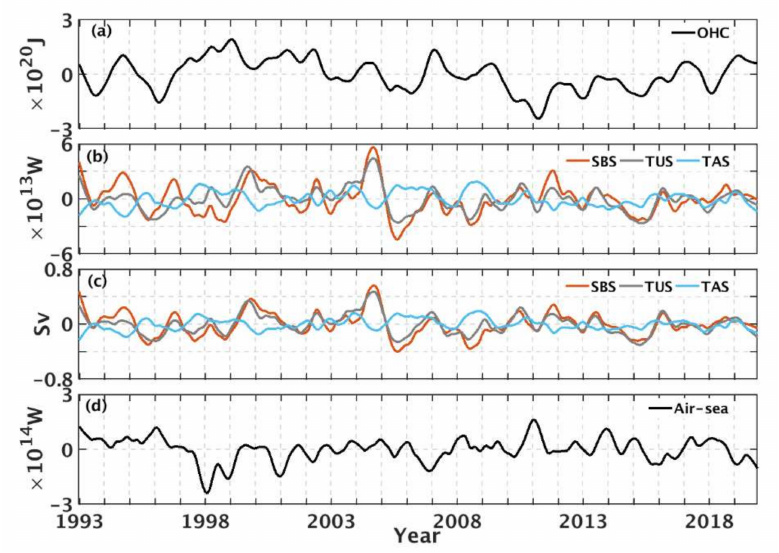
Figure 6. ( a ) Interannual OHC variation integrated over the BYECS from 1993 to 2019. ( b ) Interannual variation of heat transport across the SBS (orange solid line), TUS (gray solid line), and TAS (blue solid line). ( c ) Interannual variation of volume transport across the SBS (orange solid line), TUS (gray solid line), and TAS (blue solid line). ( d ) Interannual variation of air-sea heat flux integrated over the BYECS.